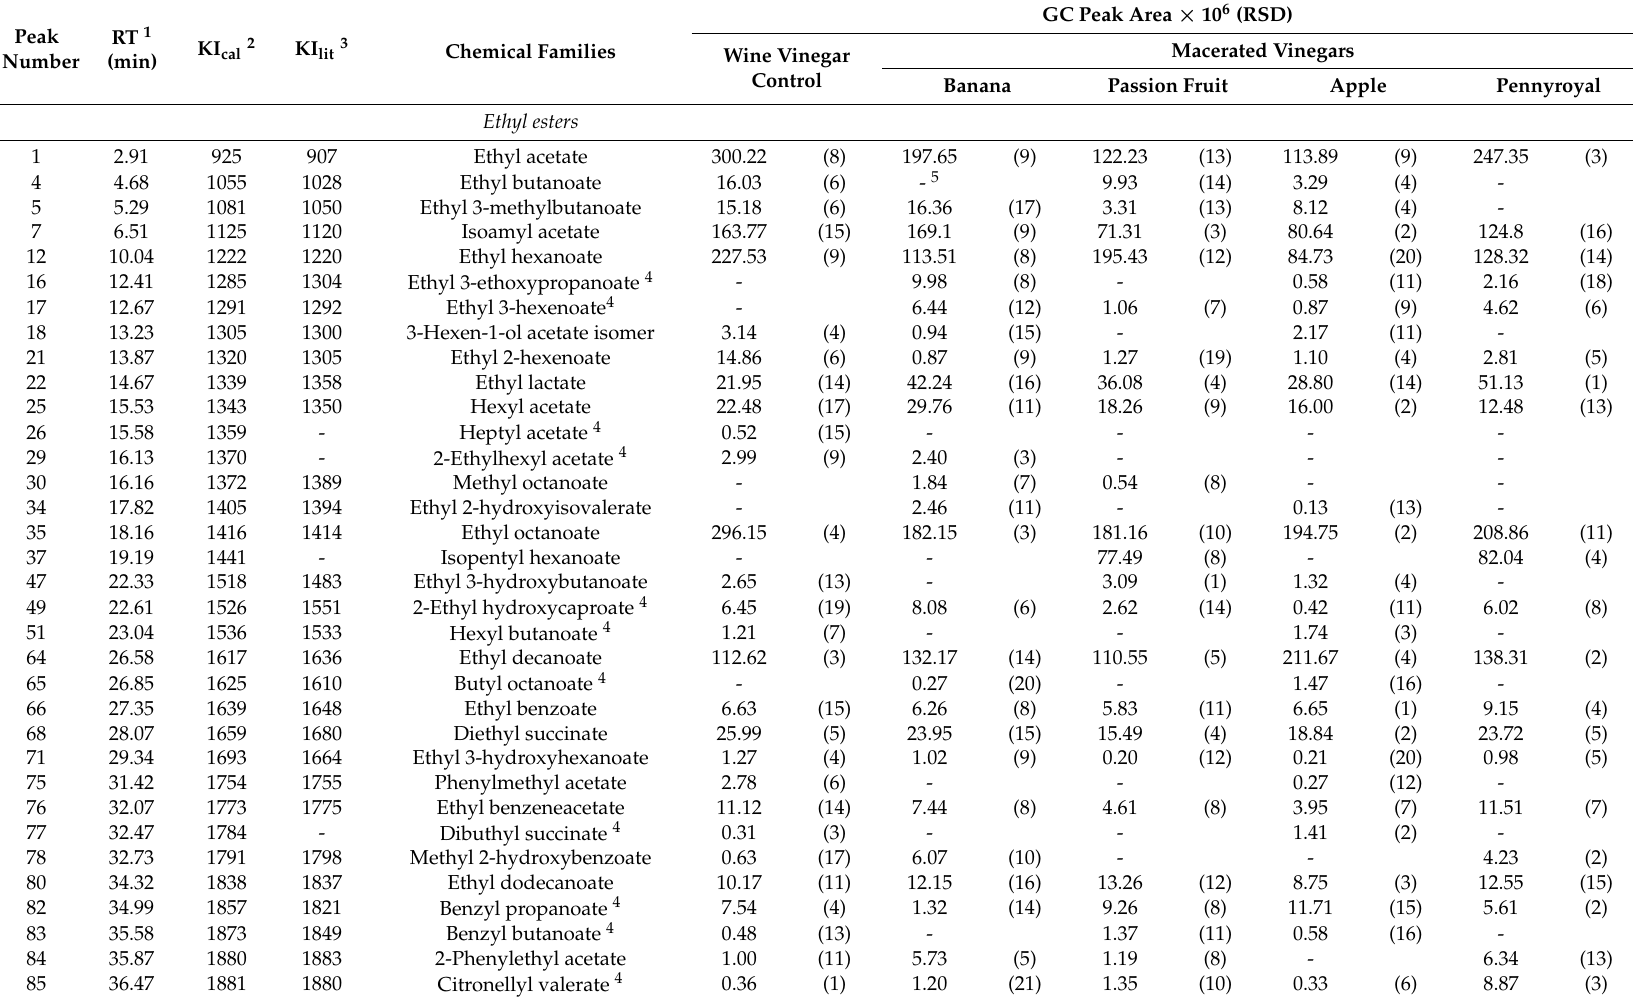
Table 1. Volatile organic compounds (VOCs) identified in wine-based aromatic vinegars (WBAVs) by headspace solid-phase microextraction (HS-SPME) PDMS /GC-MS.